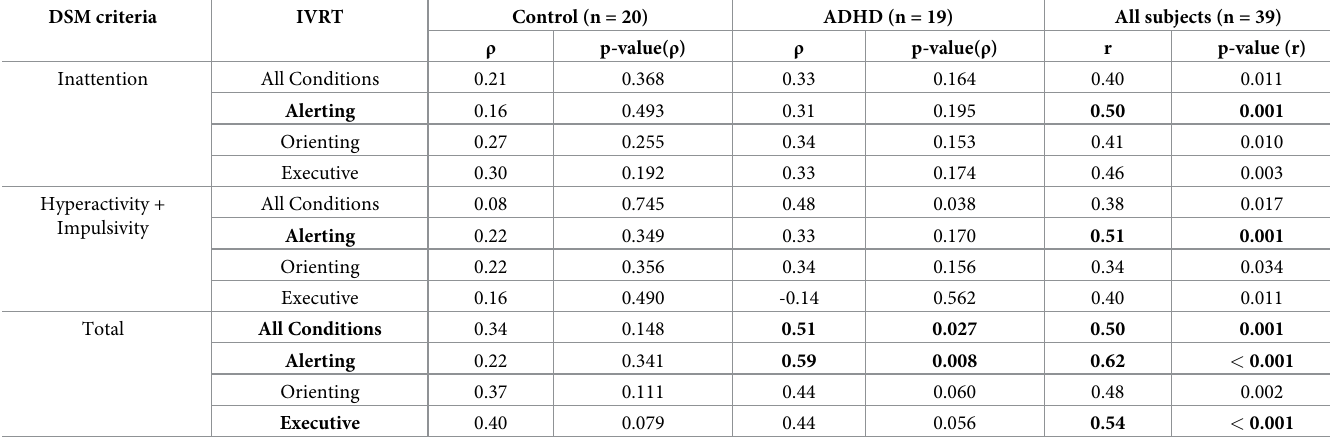
Table 2. Correlation between DSM scores of ADHD and intraindividual variation in reaction time (IVRT) in ANT. DSM criteria Inattention